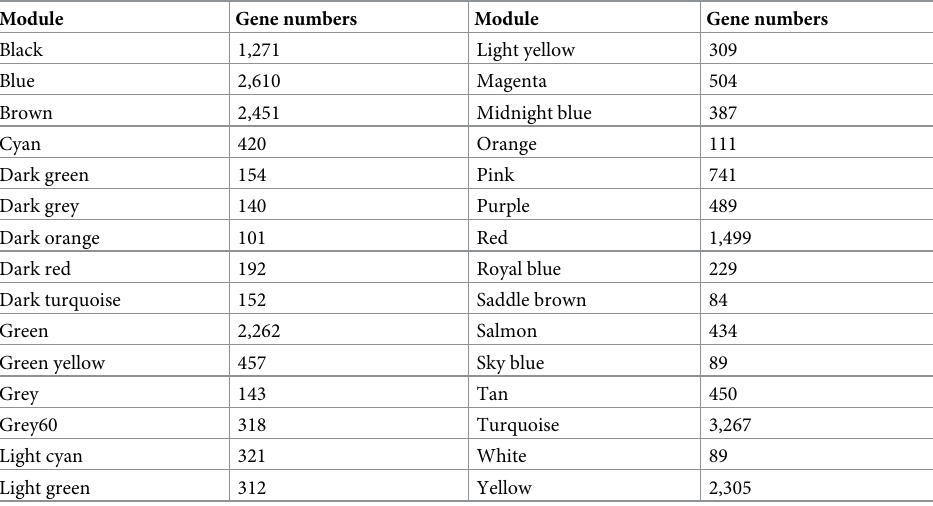
Table 3. Number of genes enriched in each module. Module